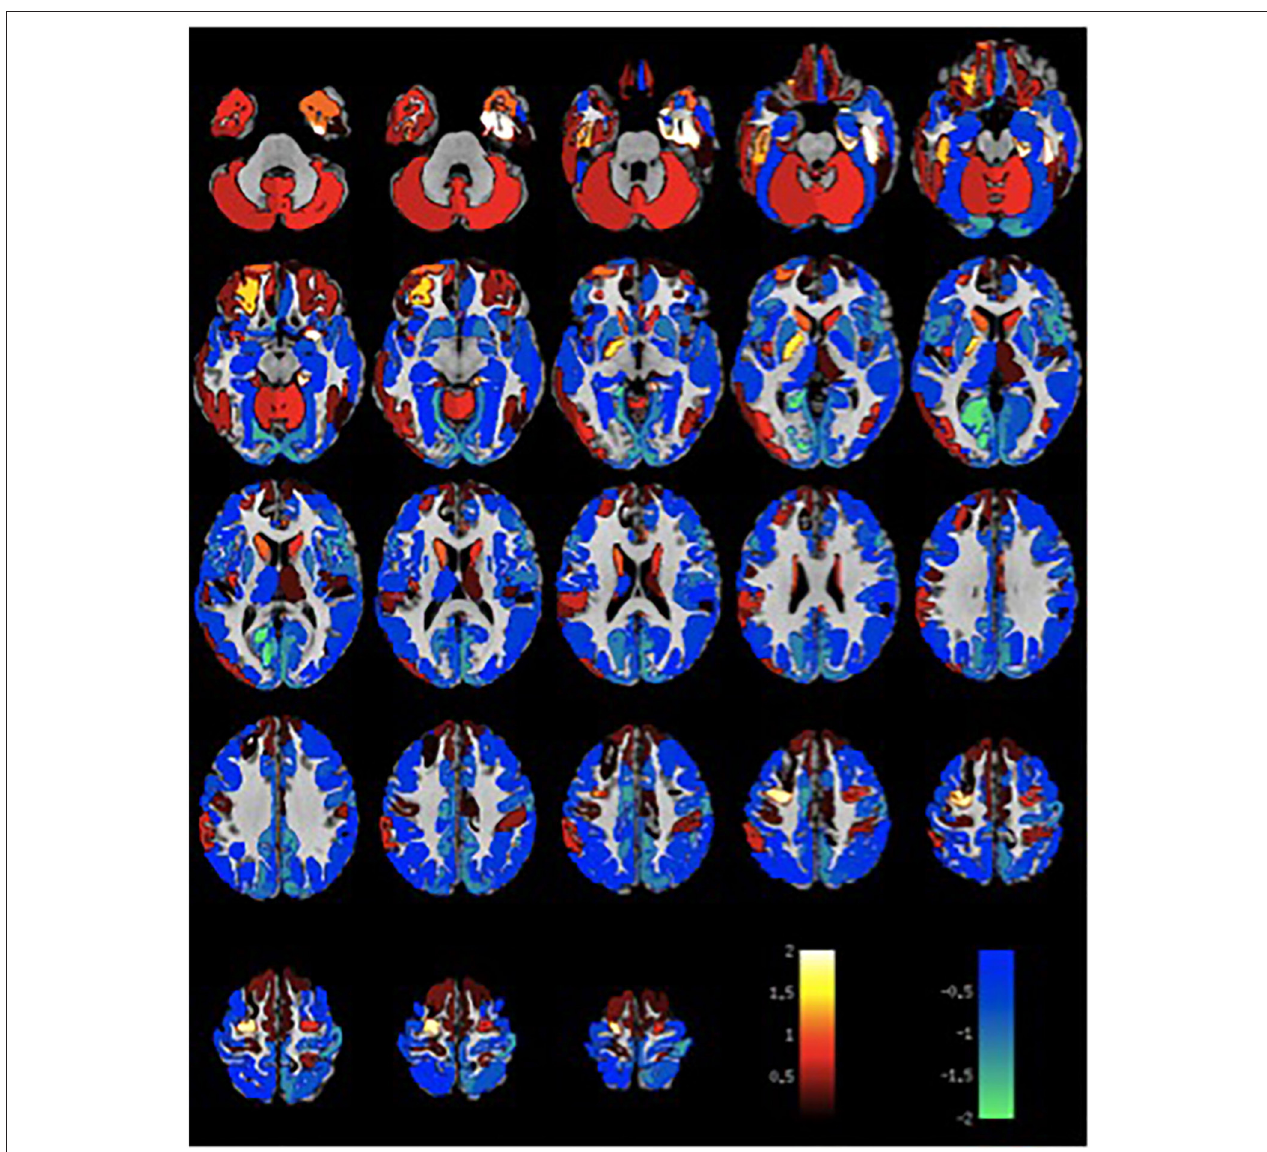
FIGURE 2 | Differences in gray matter volume in patients with visual misperceptions and Parkinson Disease compared to patients with Parkinson Disease without hallucinations or misperceptions. Color scale shows t -statistic for differences in gray matter volume in cortical regions of the Destrieux atlas and 14 subcortical regions with automated FreeSurfer